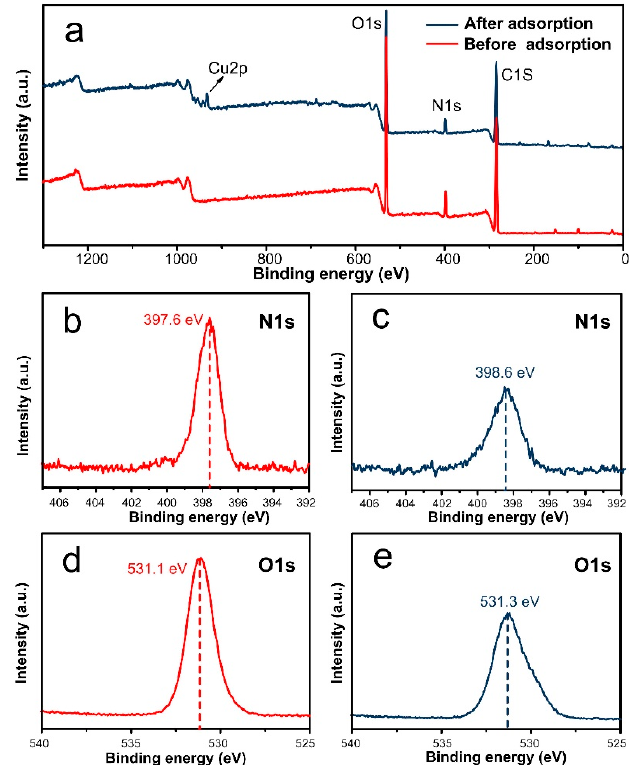
Figure 11. XPS spectrum of ( a ) CS-L3 before and after the adsorption of Cu(II), high-resolution scan of N1s ( b ) before and ( c ) after the adsorption of Cu(II), and high-resolution scan of O1s ( d ) before and ( e ) after the adsorption.